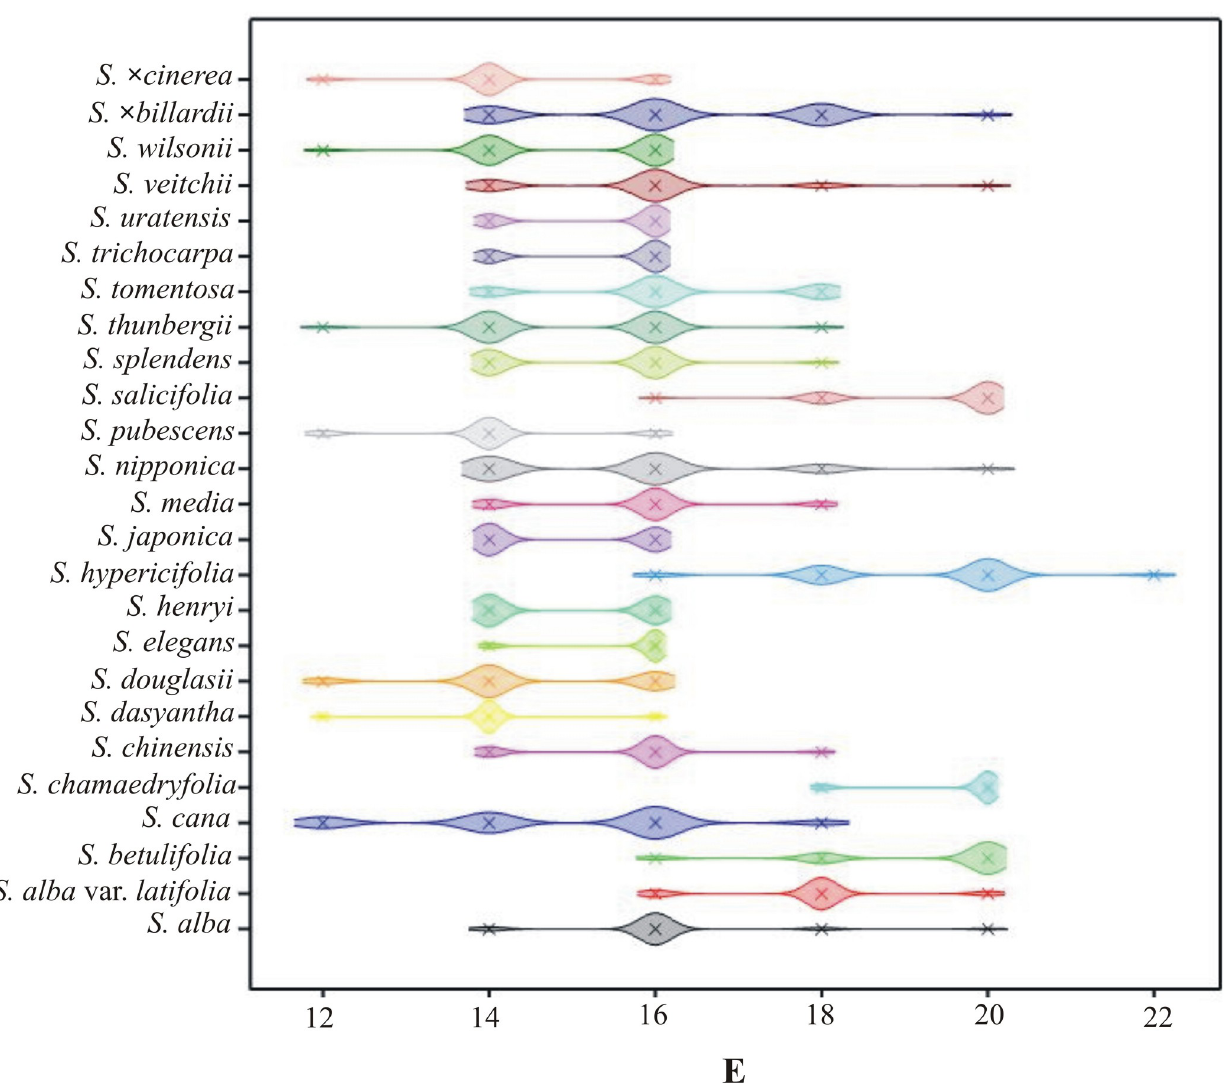
Fig 7. The density plot of E by Spiraea